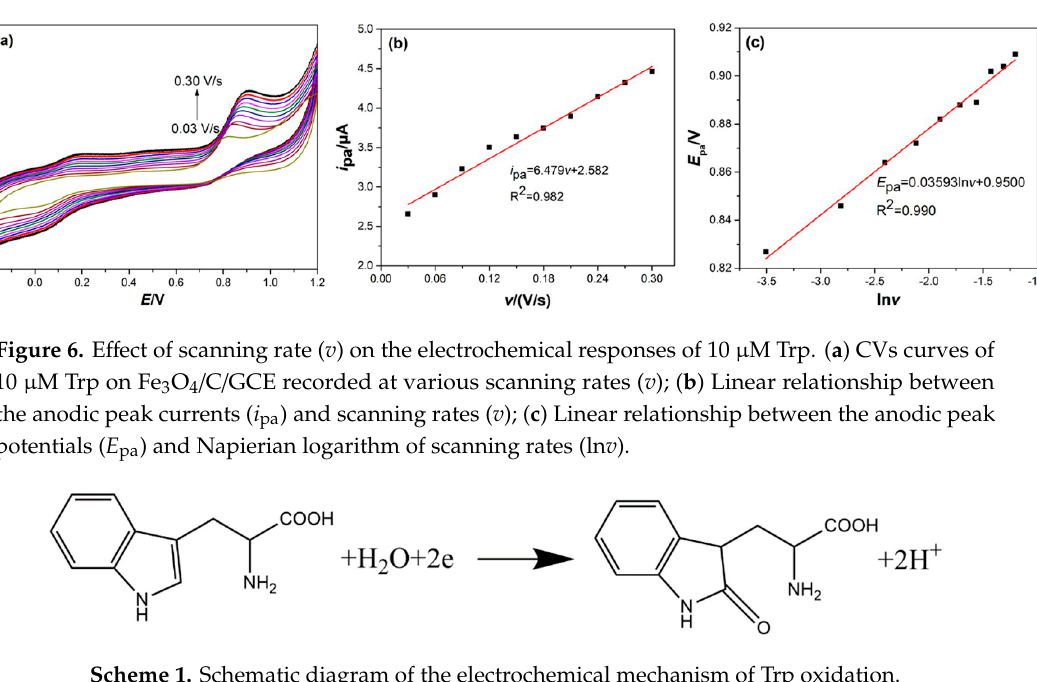
Scheme 1. Schematic diagram of the electrochemical mechanism of Trp oxidation.